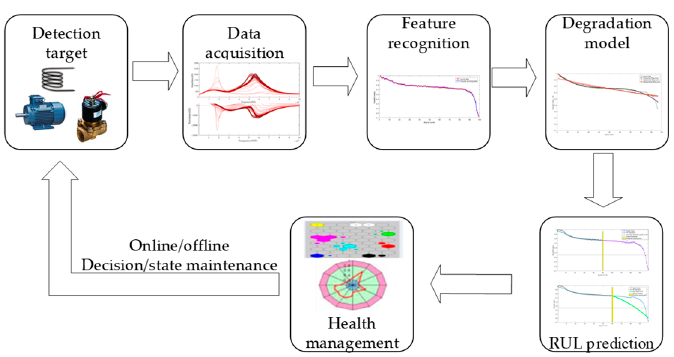
Figure 1. The prognostics and health management (PHM) implementation scheme of the electromagnetic coil.